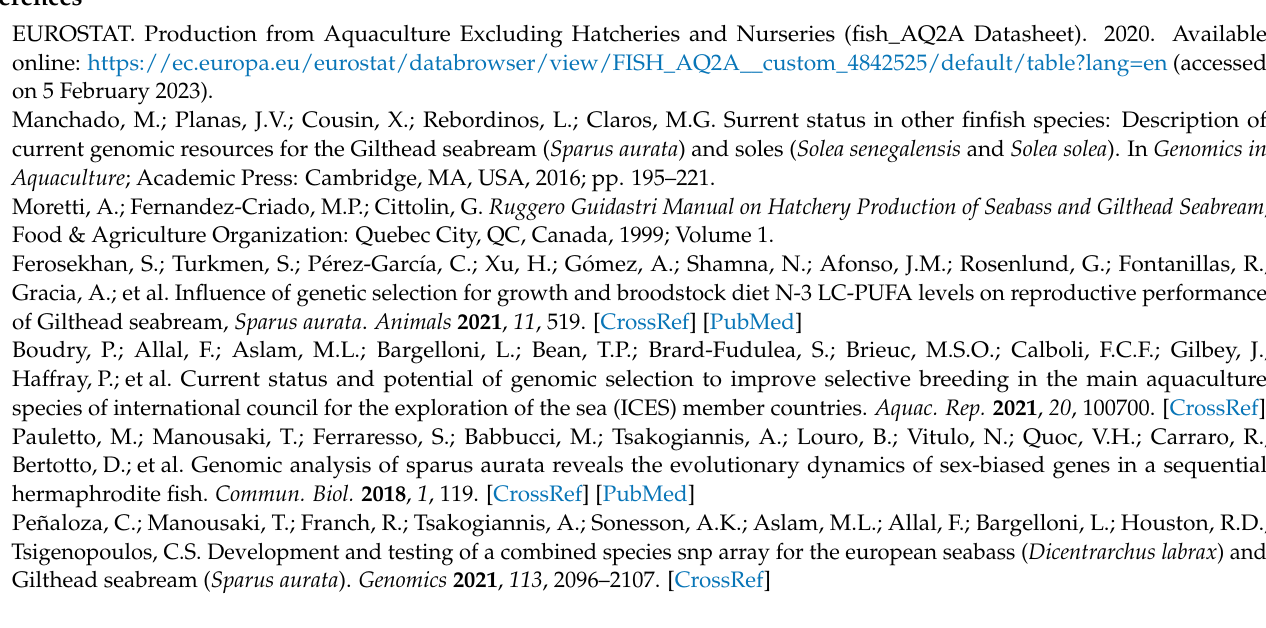
pools. Table S3: F ST regions of high divergence in the comparison between nuclei A and B. Reported data includes: chromosome, beginning of the region (start), end of the region (end), size of the region (size) and genes contained in the regions (genes). Table S4: F ST regions of high divergence in the comparison between nuclei A and C. Reported data includes: chromosome, beginning of the region (start), end of the region (end), size of the region (size) and genes contained in the regions (genes). Table S5: F ST regions of high divergence in the comparison between nuclei B and C. Reported data includes: chromosome, begin of the region (start), end of the region (end), size of the region (size) and genes contained in the regions (genes). Table S6: Variant effect predictor of high impact variation in the F ST regions. Table S7: Non-redundant Gene Ontology (GO) Term list for the different comparisons, including GO term code, GO term biological process name, fold enrichment, false discovery rate (FDR) value and genes included in the